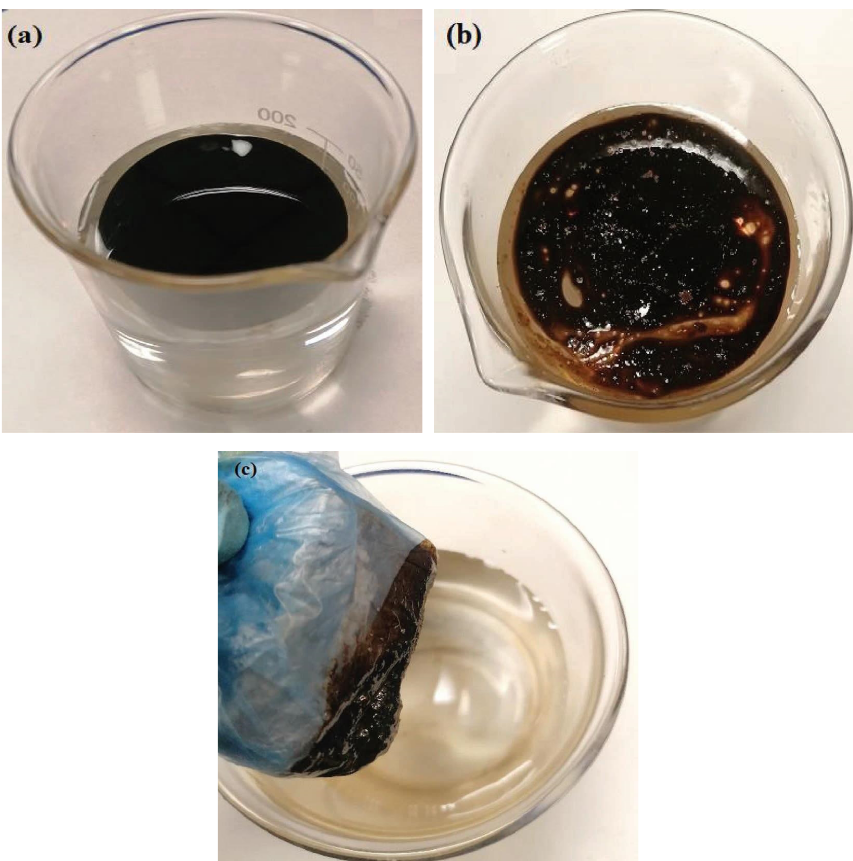
Figure 10: Optical images of (a) oil spill on the water surface, (b) dispersed AU-MNPs on the crude oil surface at a ratio of 1:2, and (c) the collected AU-MNPs with crude oil adsorbed on their surface using an external magnet.